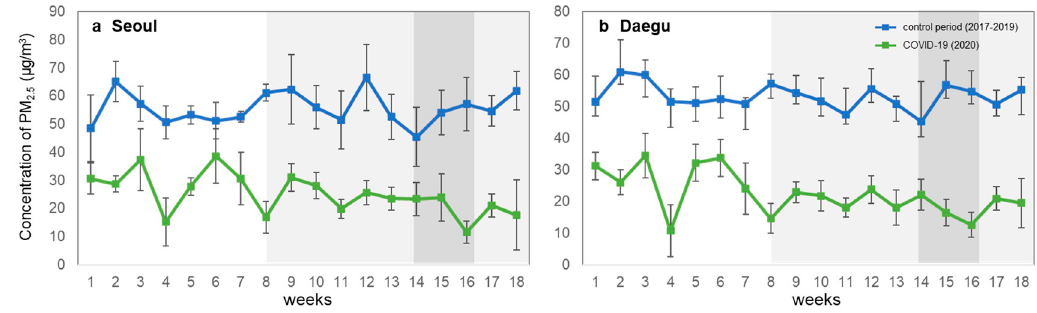
Figure 3. Comparison of average PM 2.5 concentrations by week between 2020 and the previous three years in ( a ) Seoul and ( b ) Daegu. Highlighted shadow represents the level of social distancing. The error bar means standard deviation.